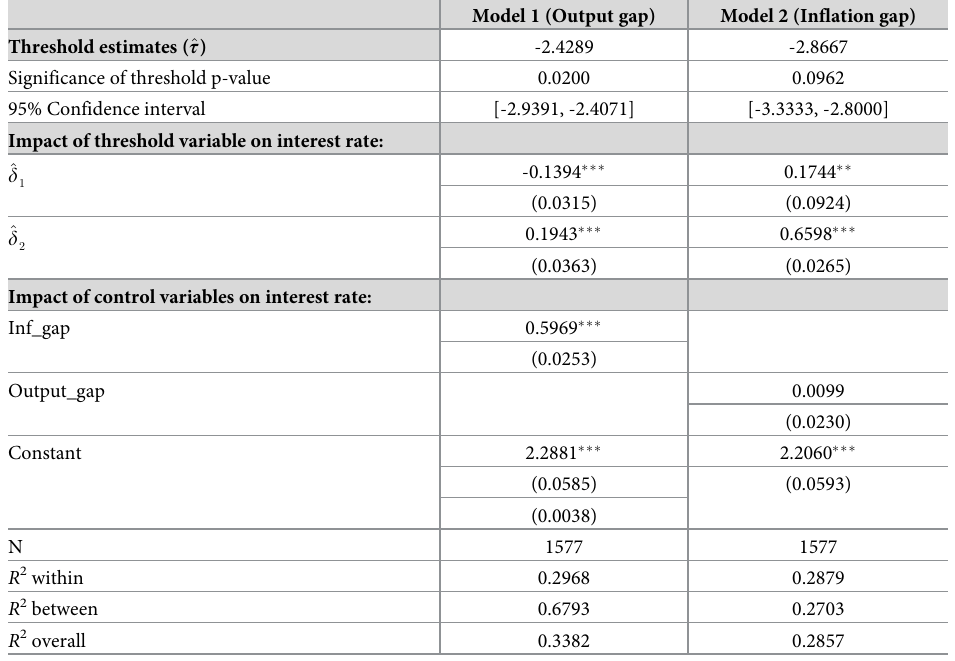
Table 2. Results of output gap and its impact on interest